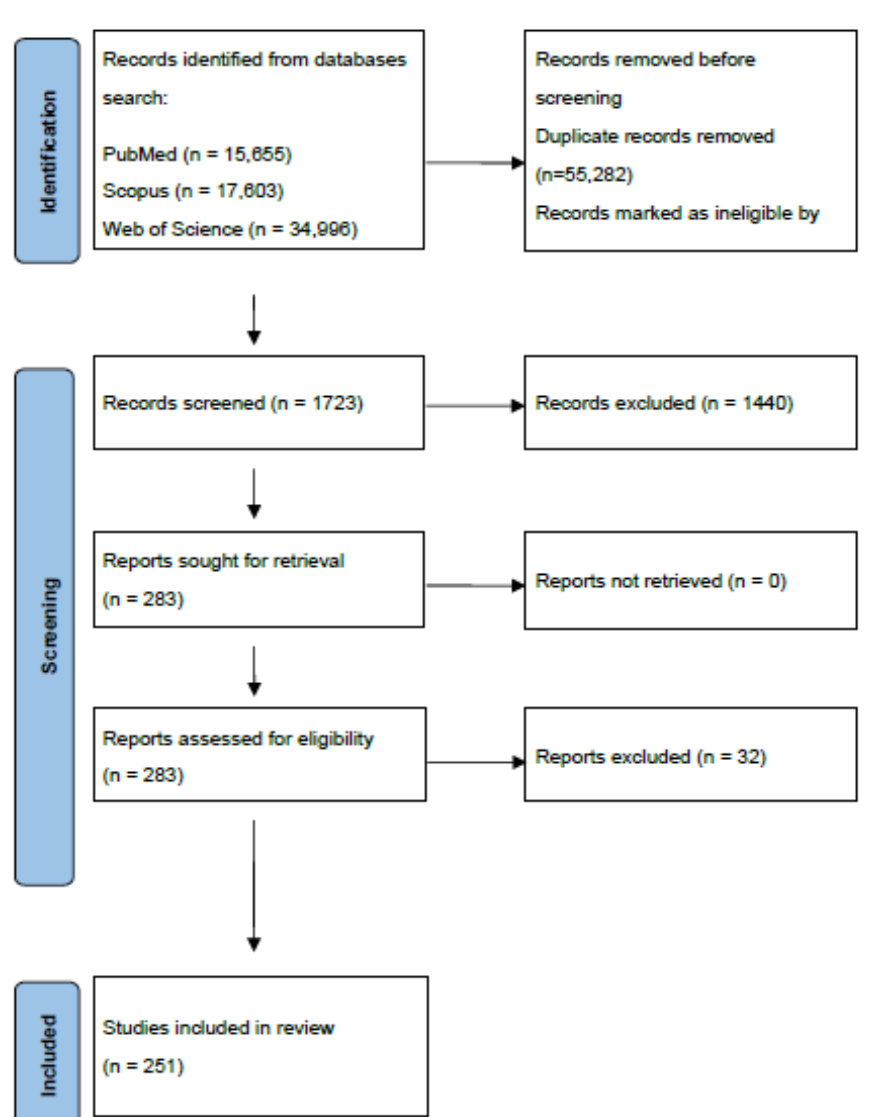
Figure 1. Flowchart of the identification and selection of studies according to the 2020 PRISMA statement.